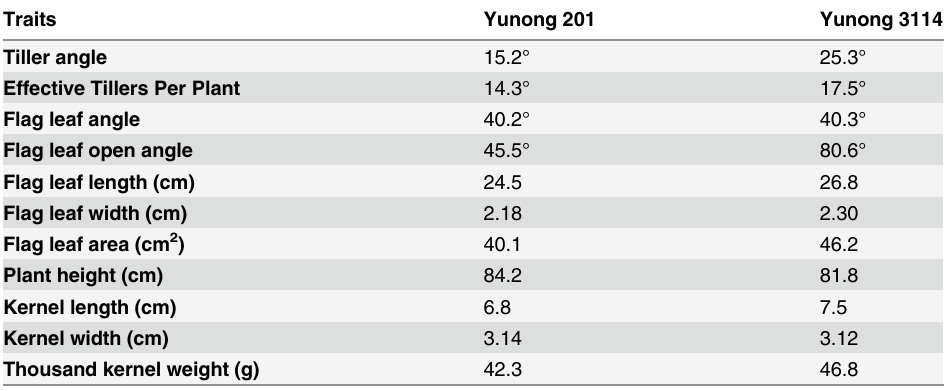
Table 1. Comparison of agronomic traits of Yunong 201 and Yunong